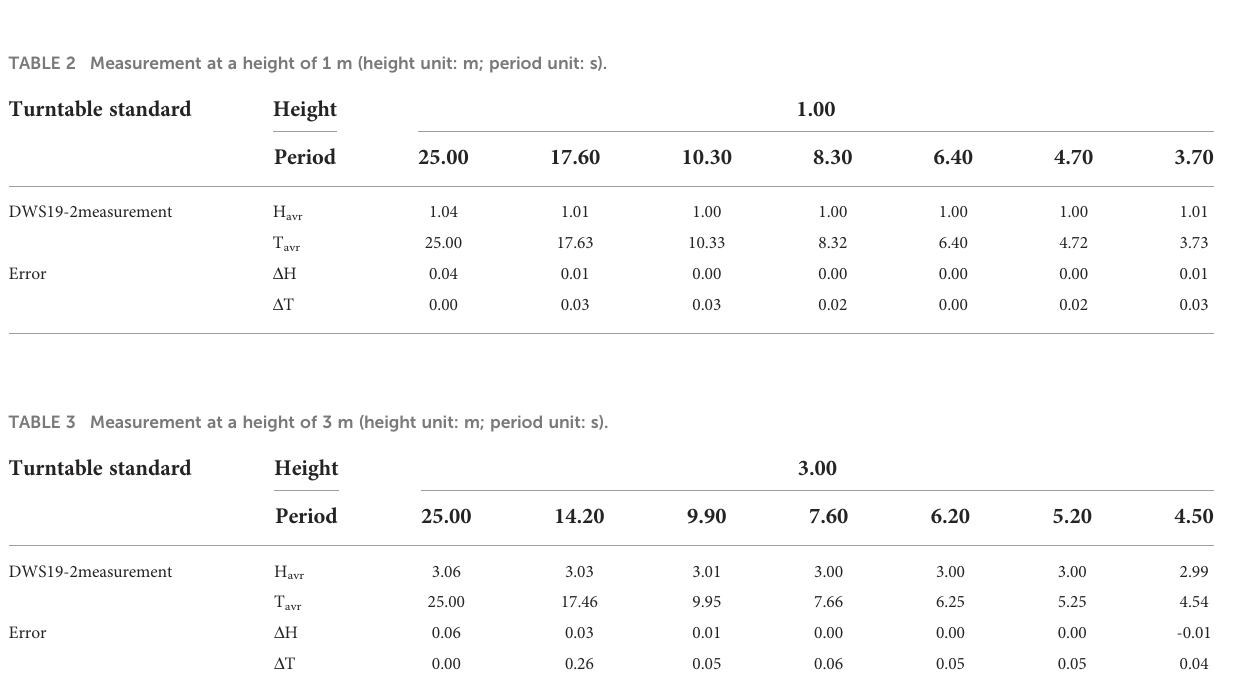
Overall, for DWS19-2, at a height of 1 m, the errors in height measurement were within 1% (except for the